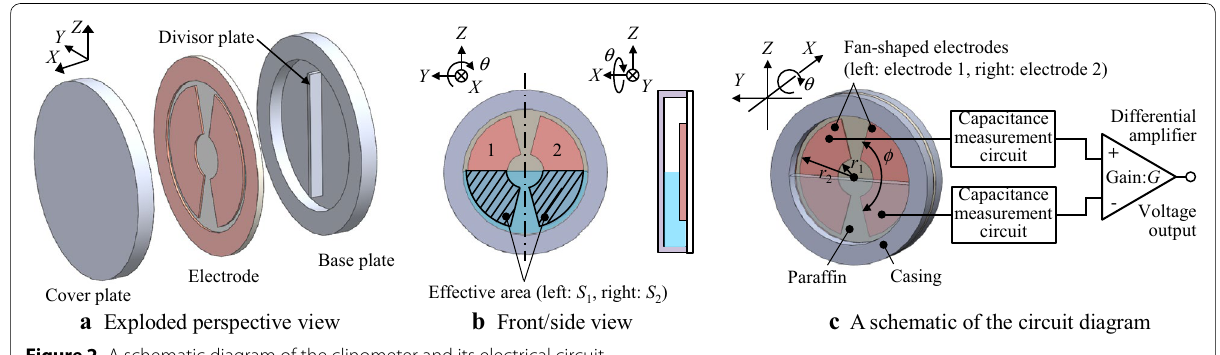
Figure 2 A schematic diagram of the clinometer and its electrical